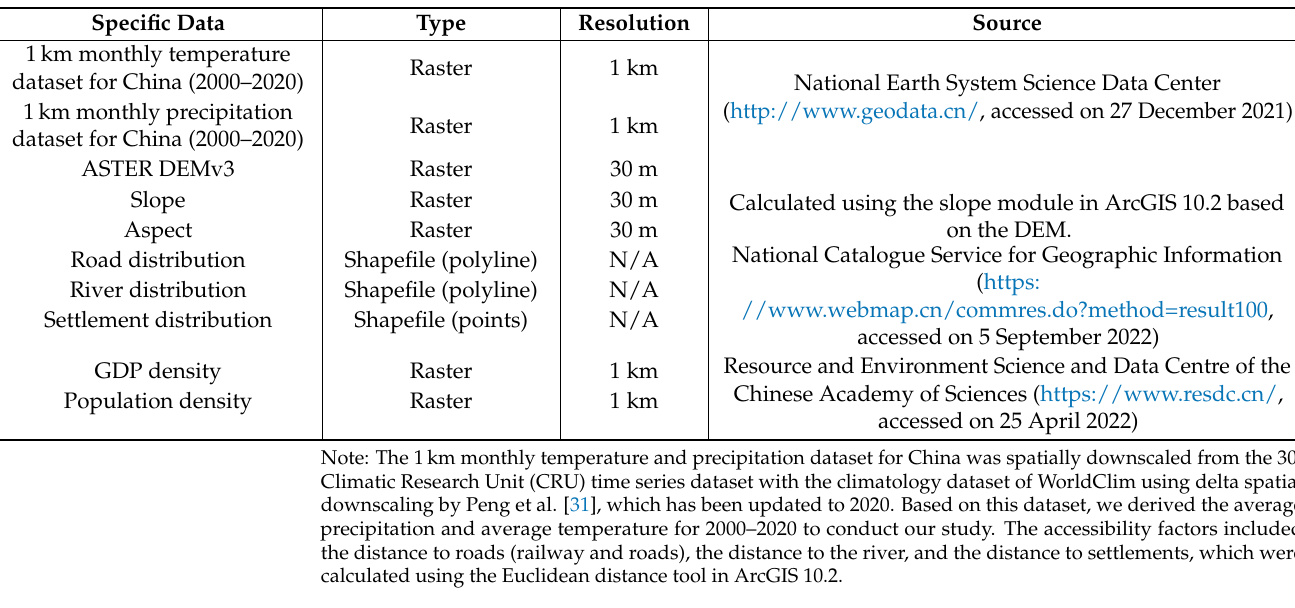
Table 1. Specific description of each driver and its